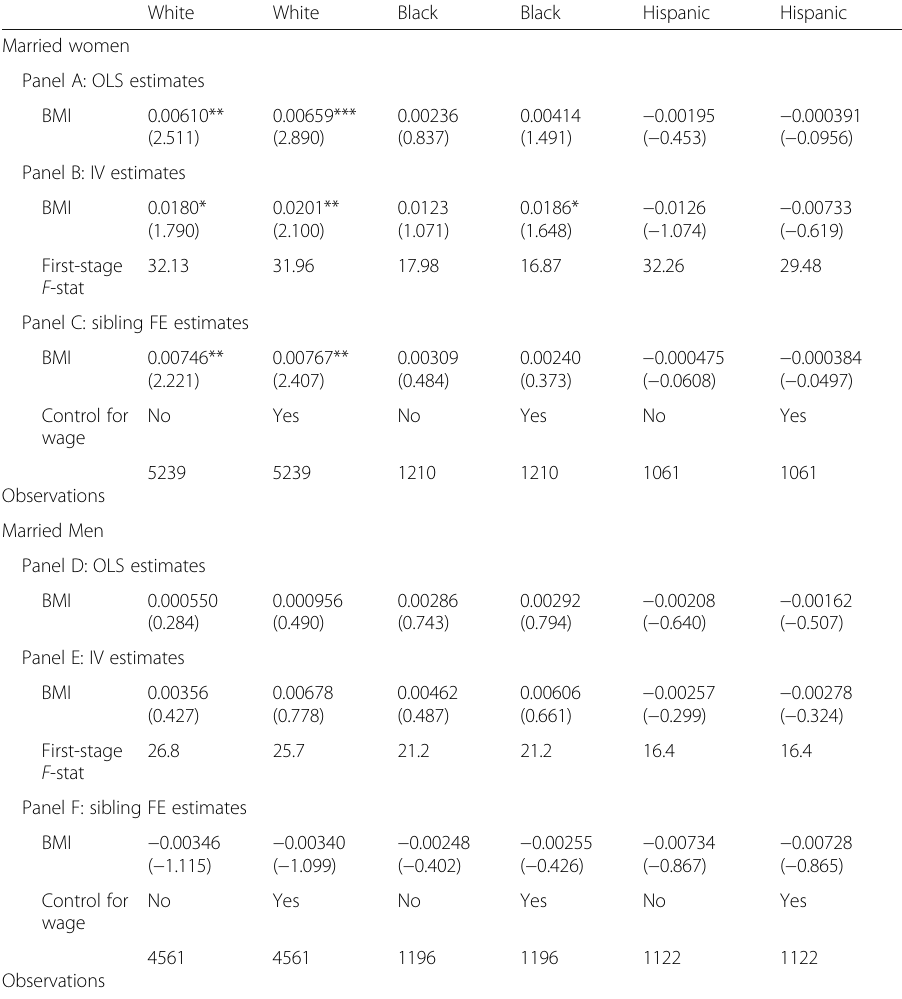
Table 2 BMI coefficients in log hours of work regressions for married respondents: OLS, IV, and FE